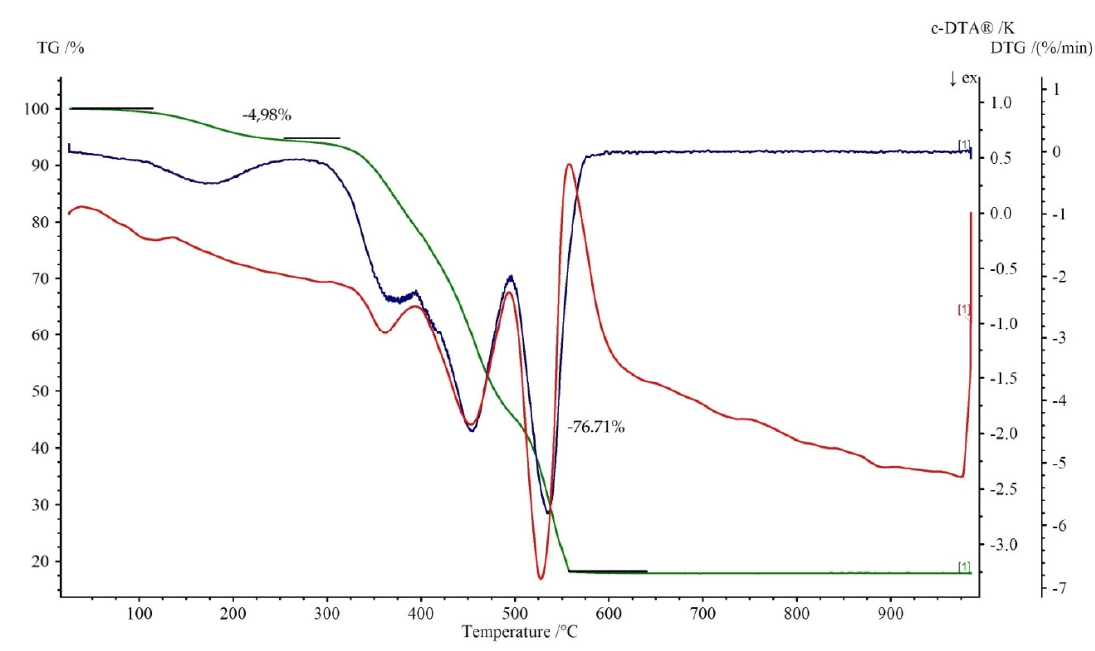
Figure 8. Thermoanalytical curves of 2 . TG is in green with percentage weight losses, DTG is in blue while DTA is in red.